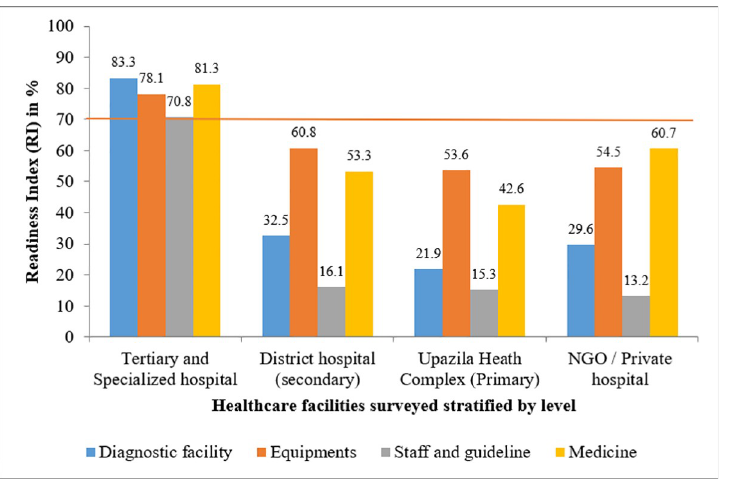
Fig 3. Domain specific CRD service readiness index by facility level (the red line indicates the cut off value 70%, above which a facility is considered to be ‘ready’ to provide CRD services).